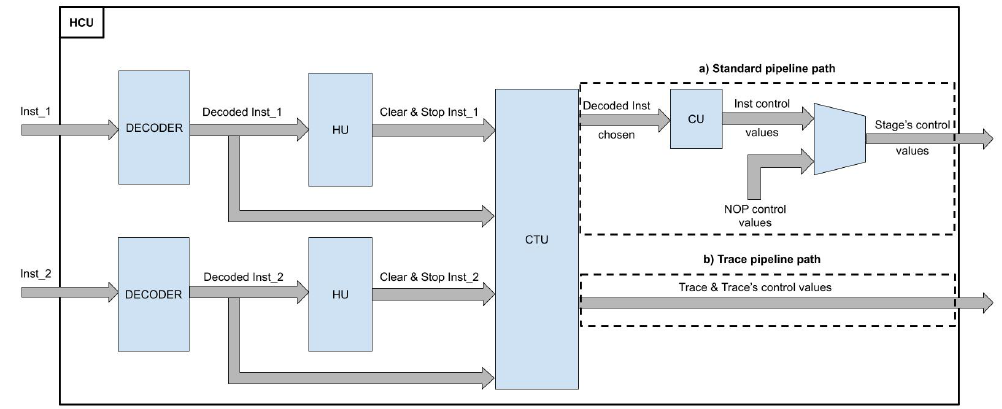
Figure 13. Resulting modifications applied on the RV32Xtrace Hazard Control Unit